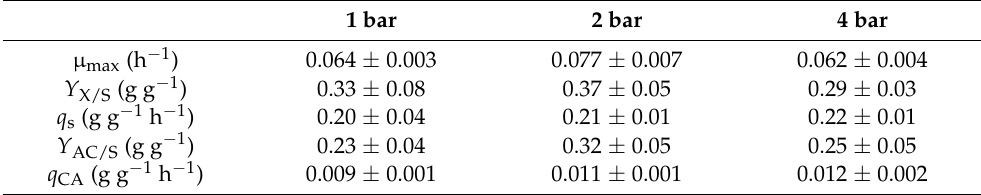
Table 1. Effect of increased air pressure on maximum specific growth rate ( µ max ), biomass yield ( Y X/S ), specific consumption rate ( q S ), citric acid yield ( Y CA/S ), and maximum specific citric acid productivity ( q CA ) during bath cultures of Y. lipolytica W29 in a pressurized bioreactor. Data are presented as the average and standard deviation of two independent experiments. 1 bar 2 bar 4